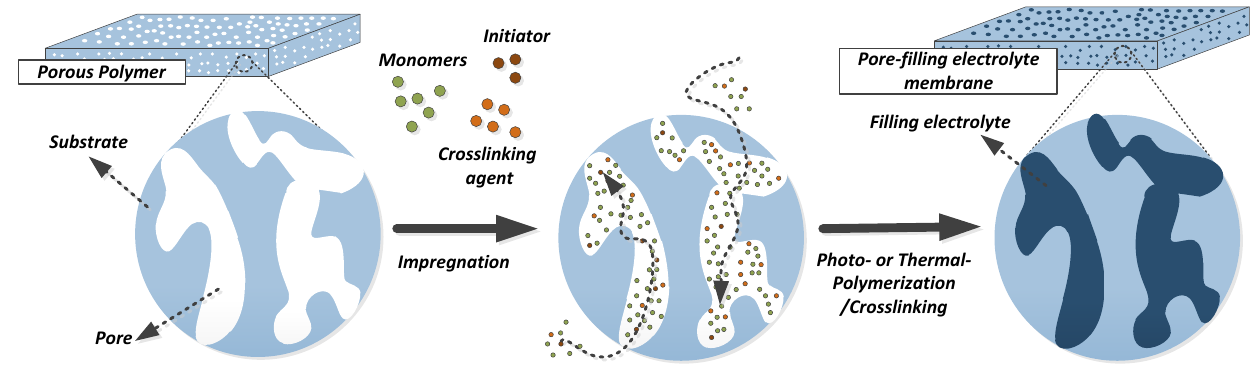
Figure 12. The concept of a pore-filling electrolyte